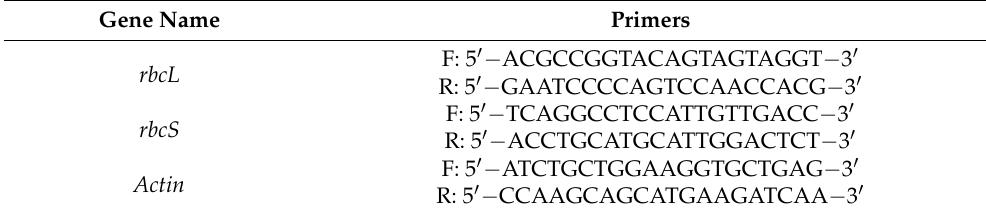
Table 1. Primers for gene expression analysis using real − time